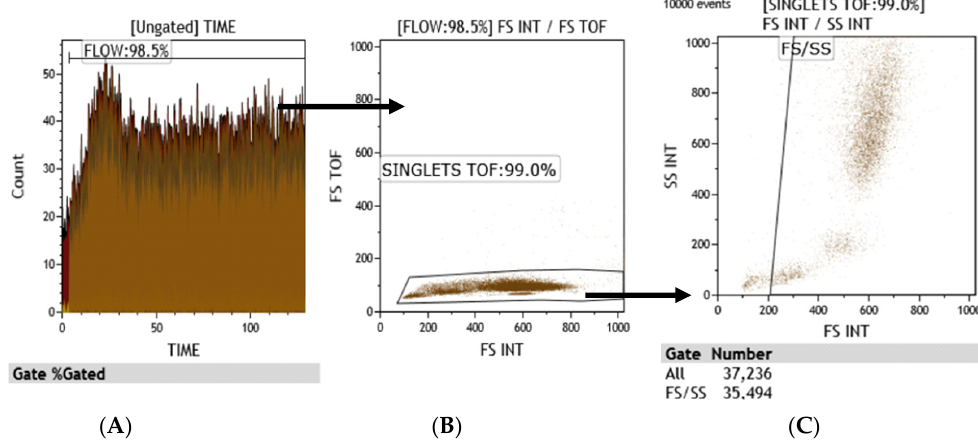
Figure 2. All cells-gate plays a central role in the identification of the subset cellular population of peripheral blood. All irregularities were excluded by the definition of Flow-gates ( A ); doublets were excluded by a singlets gate drawn in the central dot plot ( B ), forward scatter signal (FS) integral (INT) versus time of flight (TOF). Finally ( C ), all cells-gate was drawn on its FS vs. a side scatter (SS) characteristic. In this gate, the shifted events to the left, lower FS, were considered dead or dying cells and were removed from the analysis.